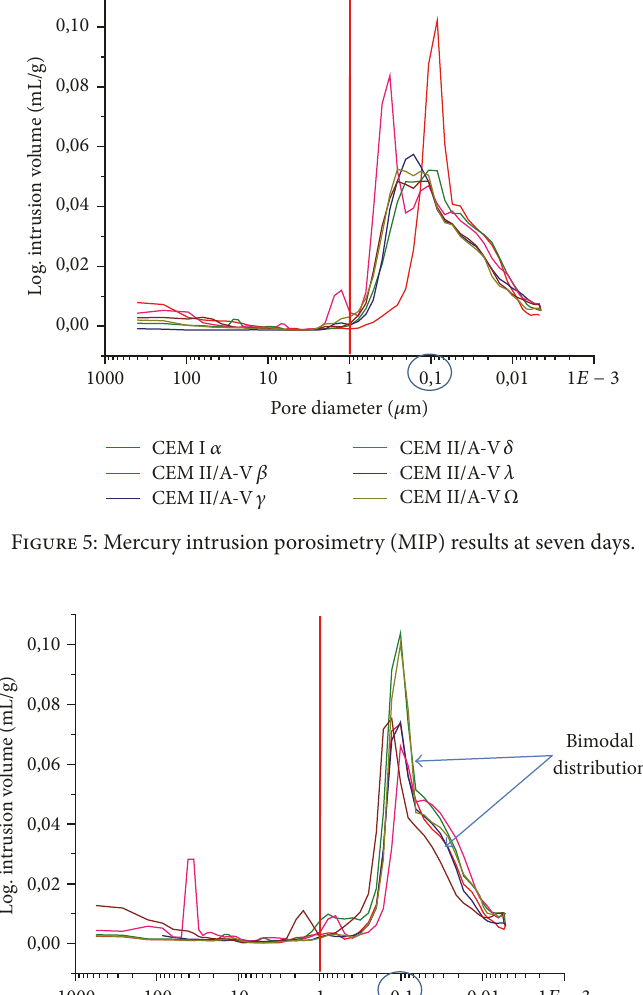
Bimodal distribution